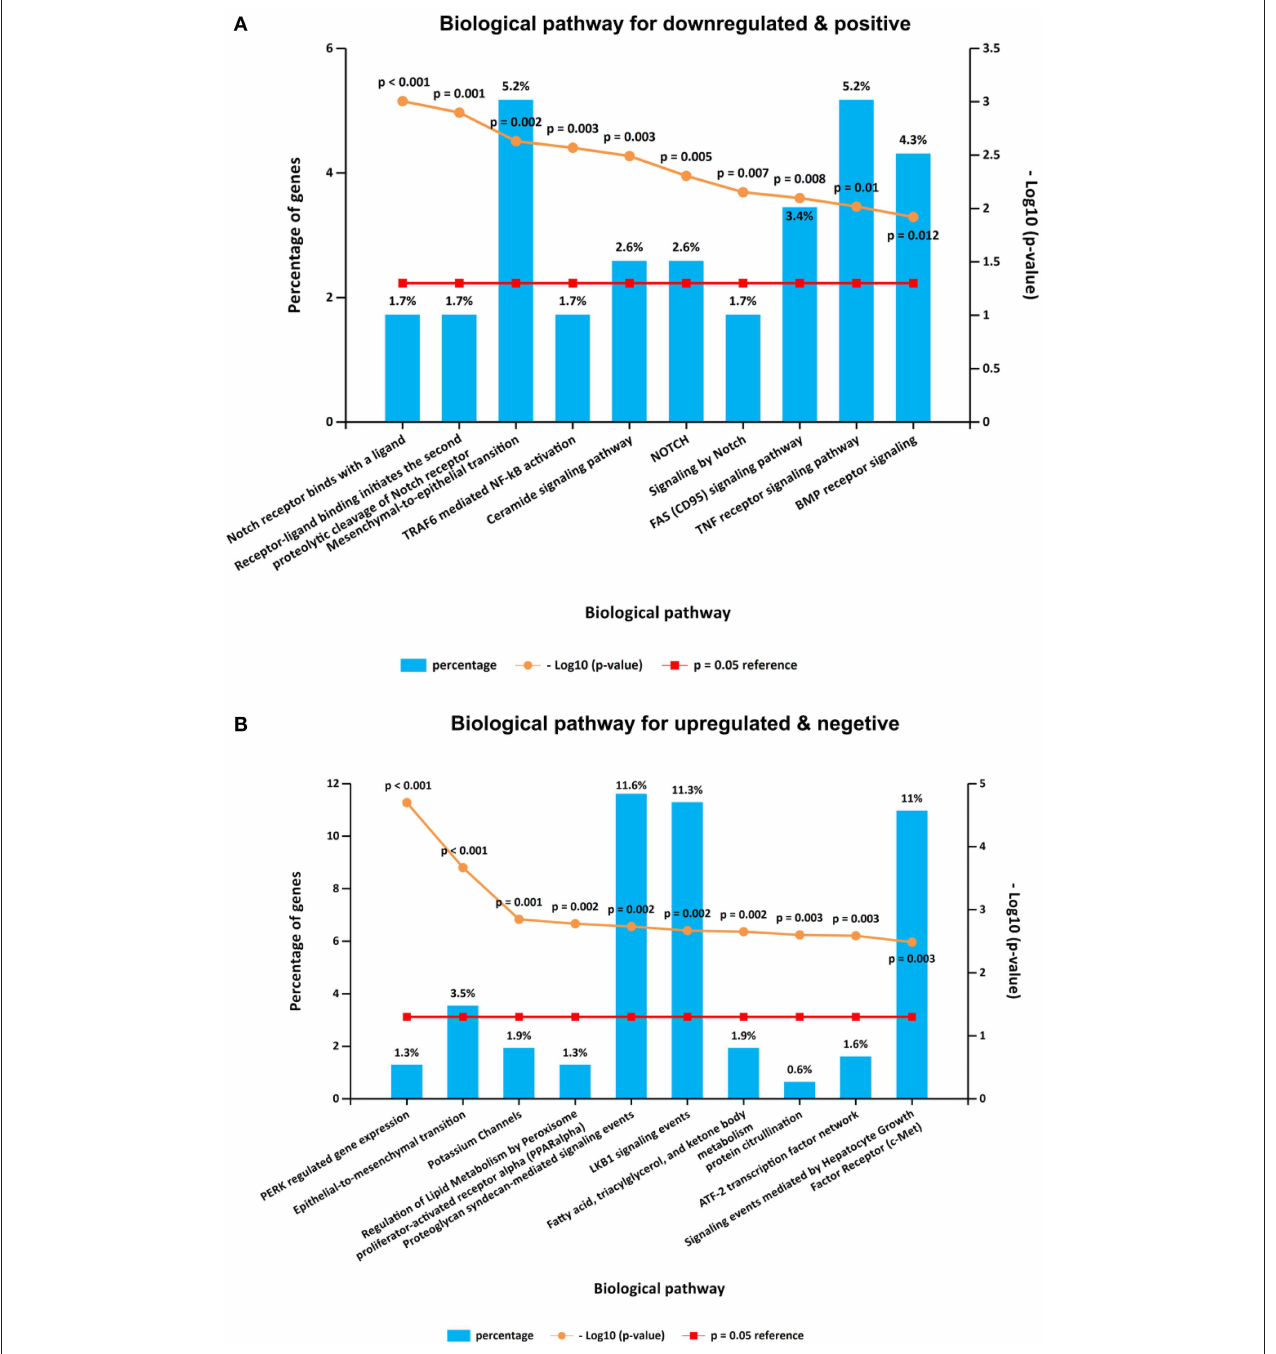
FIGURE 5 | KEGG pathway enrichment analysis of the intersecting genes. (A) Top 10 elements significantly enriched in the KEGG categories by intersecting genes of downregulated genes after CORO2A silencing and genes positively correlated with CORO2A expression with a p < 0.05. (B) Top 10 elements significantly enriched in the KEGG categories by intersecting genes of upregulated genes after CORO2A silencing and genes negatively correlated with CORO2A expression with a p < 0.05.